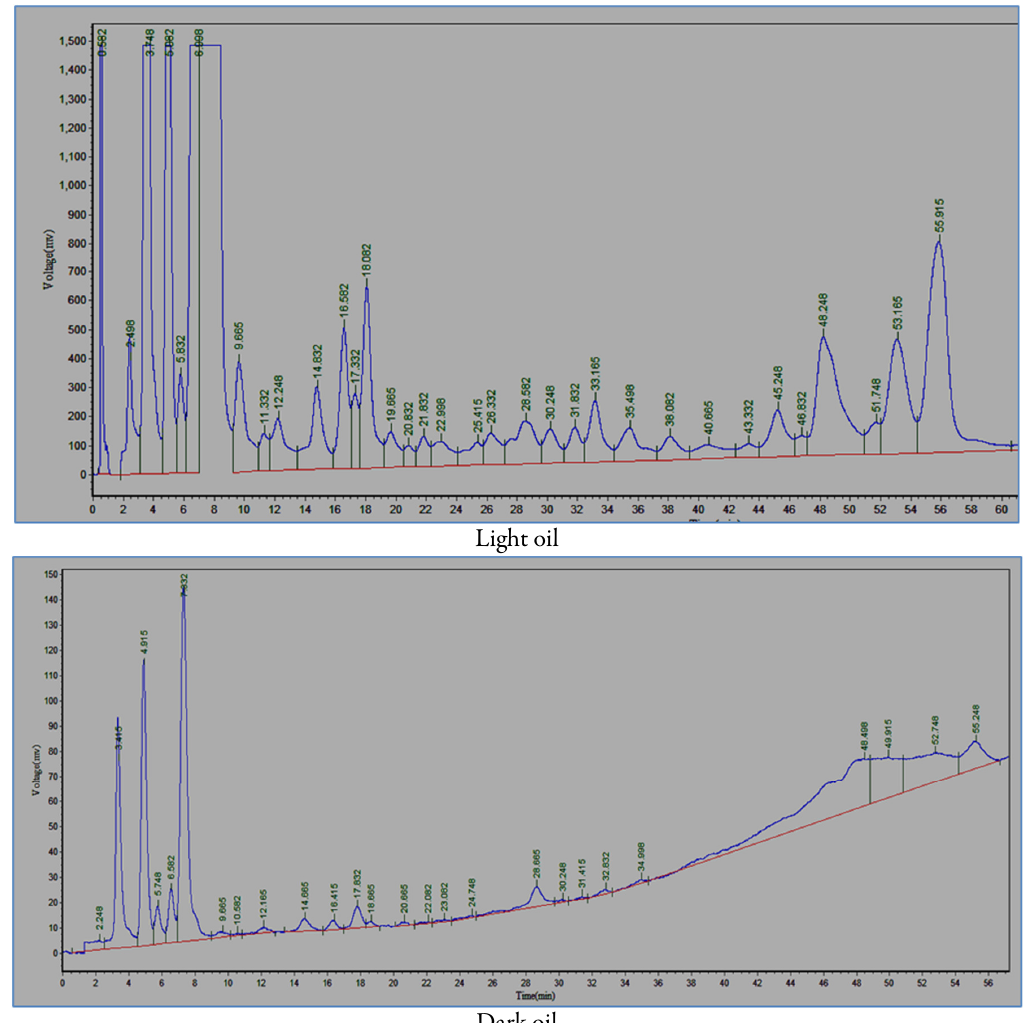
Figure 4. GC-FID profile of dark (DHBH) and light (IDHBH) colored eucalyptus essential oils